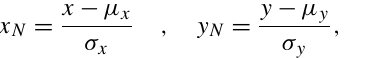
of 11 members are reasonably well corrected without elimi- nating the spread of the ensemble (Fig.